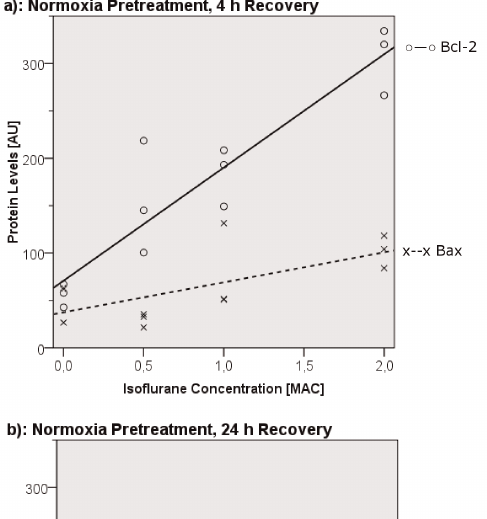
Figure 4. Bax/Bcl-2 Western Blot Curve Fit Analysis. Western blot data and curve fit of Bax (drawn as crosses and dashed lines) and Bcl-2 (rings, solid lines) in relation to hypoxia, isoflurane concentration, and delay to analysis subsequent to 2 hours of isoflurane exposure. a) No hypoxia. 4-hour latency period: significant positive linear isoflurane concentration dependency for both Bax (R 2 =0.44, P=0.02) and Bcl-2 (R 2 =0.87, P , 0.001). b) No hypoxia, 24-hour latency period: no significant concentration dependency. c & d) Hypoxia for 24 hours followed by 2 hours of reoxygenation prior to isoflurane treatment. c) 4- hour latency period: positive quadratic dose dependency for Bax (R 2 =0.71, P=0.004); d) 24-hour latency period: positive quadratic dose dependency for Bax (R 2 =0.80, P=0.001) and negative exponential dependency for Bcl-2 (R 2 =0.39,